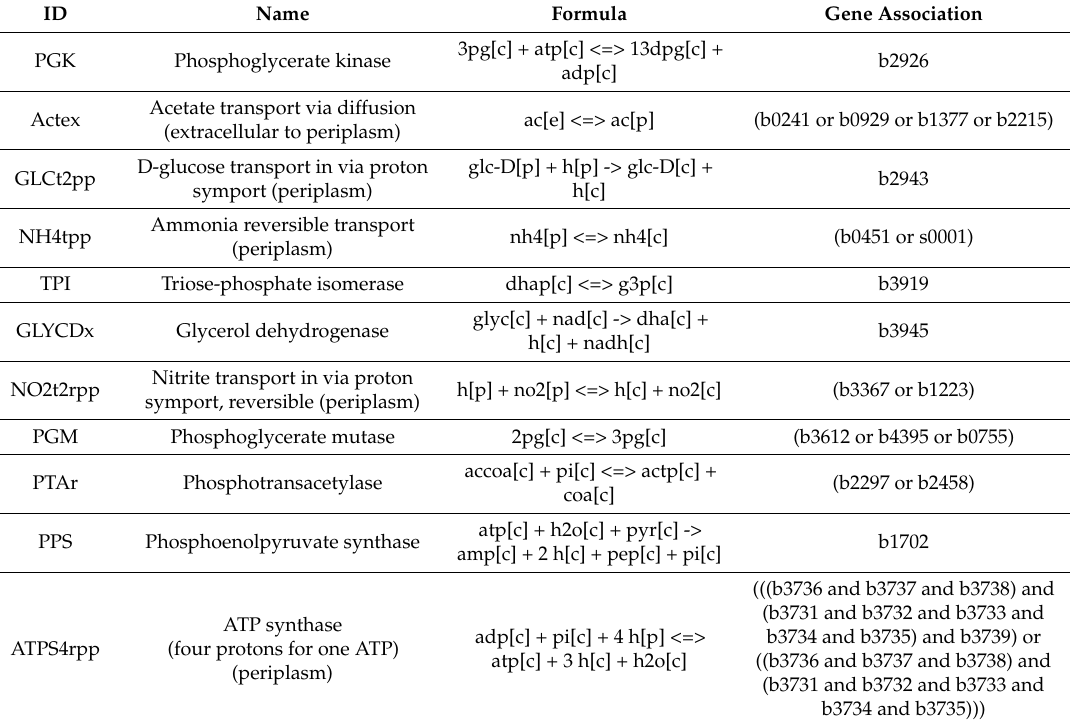
Table 3. Relevant reaction in TNT biotransformation strain